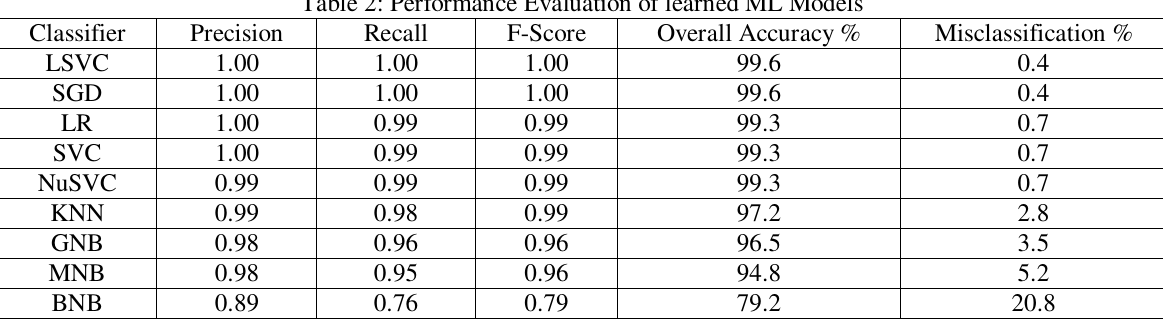
Table 2: Performance Evaluation of learned ML